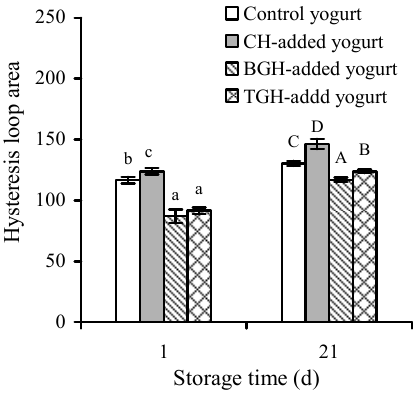
Figure 2. Measured thixotropy loop areas of the four yogurt samples stored at 4 ° C for 1 or 21 days. Different capital or lowercase letters above the columns with the same storage time indicate that one-way ANOVA of the mean values differs significantly ( p < 0.05).